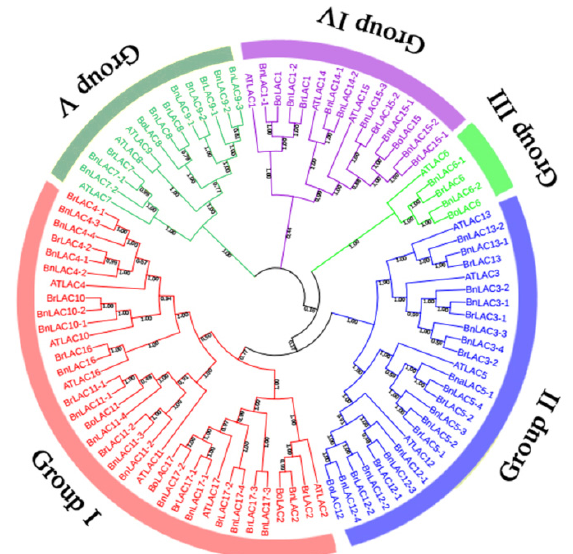
Figure 3. The cladogram of LAC proteins from A. thaliana (17), B. napus (45), B. rapa (25) and B. oleracea (8). The cladogram was constructed by the MEGA 7.0 software [31] using the neighbour-joining option with 1000 bootstrap replicates and pairwise deletion. Distinct colour segment represents different groups, bootstrap value are shown near nodes.